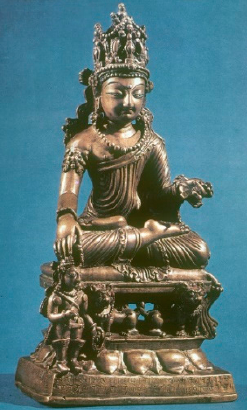
Figure 9. Buddha wearing a crown. Commissioned by King Nandivikramadityanandi, April 714 C.E. Gilgit. Brass–copper alloy with copper and silver inlays. 11 ½”H × 6”W × 4”D. Virginia Museum of Fine Arts, Richmond. Arthur and Margaret Glasgow Fund (86.120). https://alaintruong2014.files.wordpress.com/2015/01/1919.jpg.